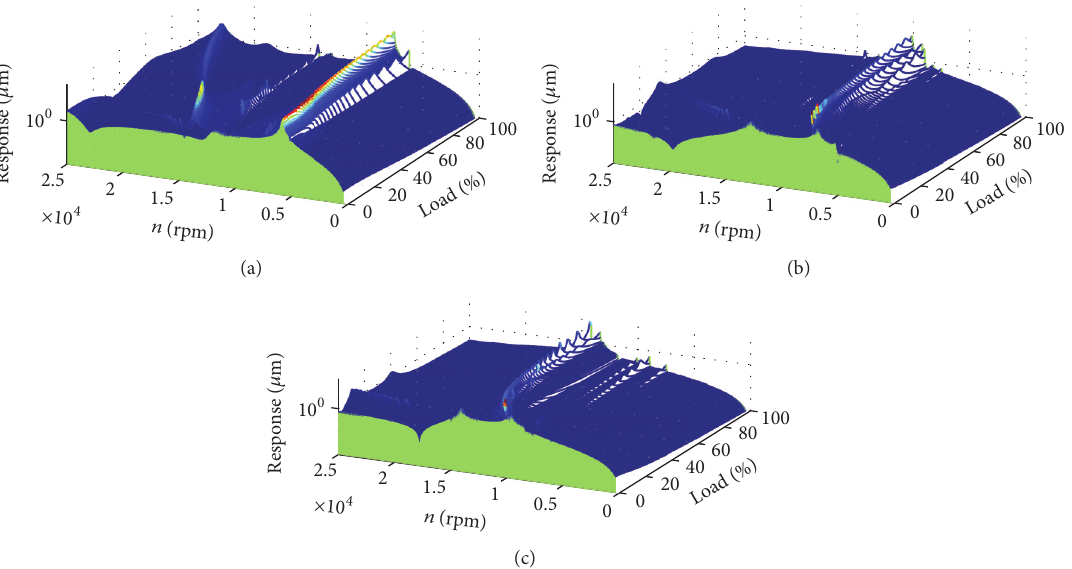
Figure 15: Unbalance response of three output shafts considering all the influence factors under the varying workload, (a) output shaft 1; (b) output shaft 2; (c) output shaft